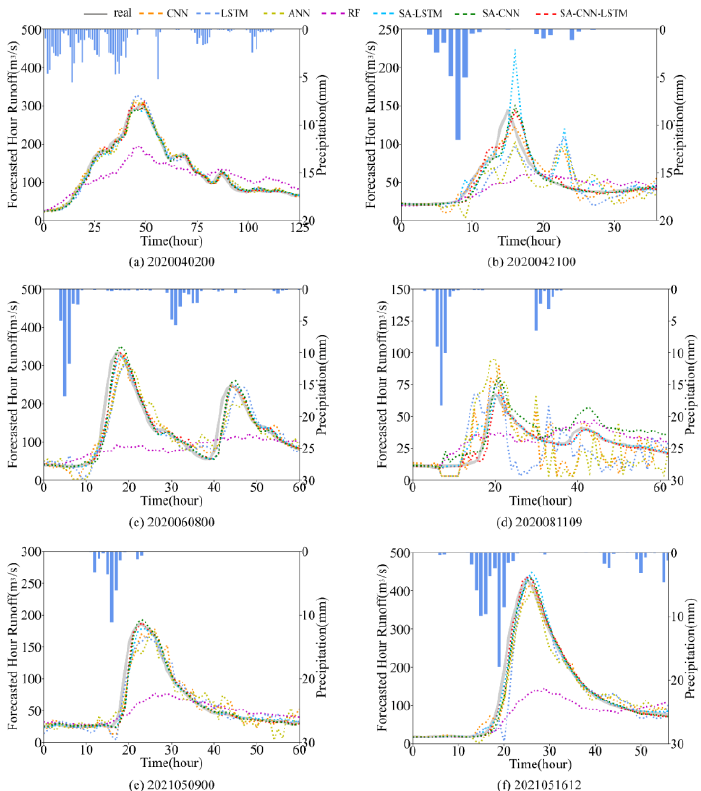
Figure 9. Comparisons of the predictions from each model with a lead time of 1 h. Table 4. Comparisons of evaluation indicators of six flood events from each model at the lead time of 1